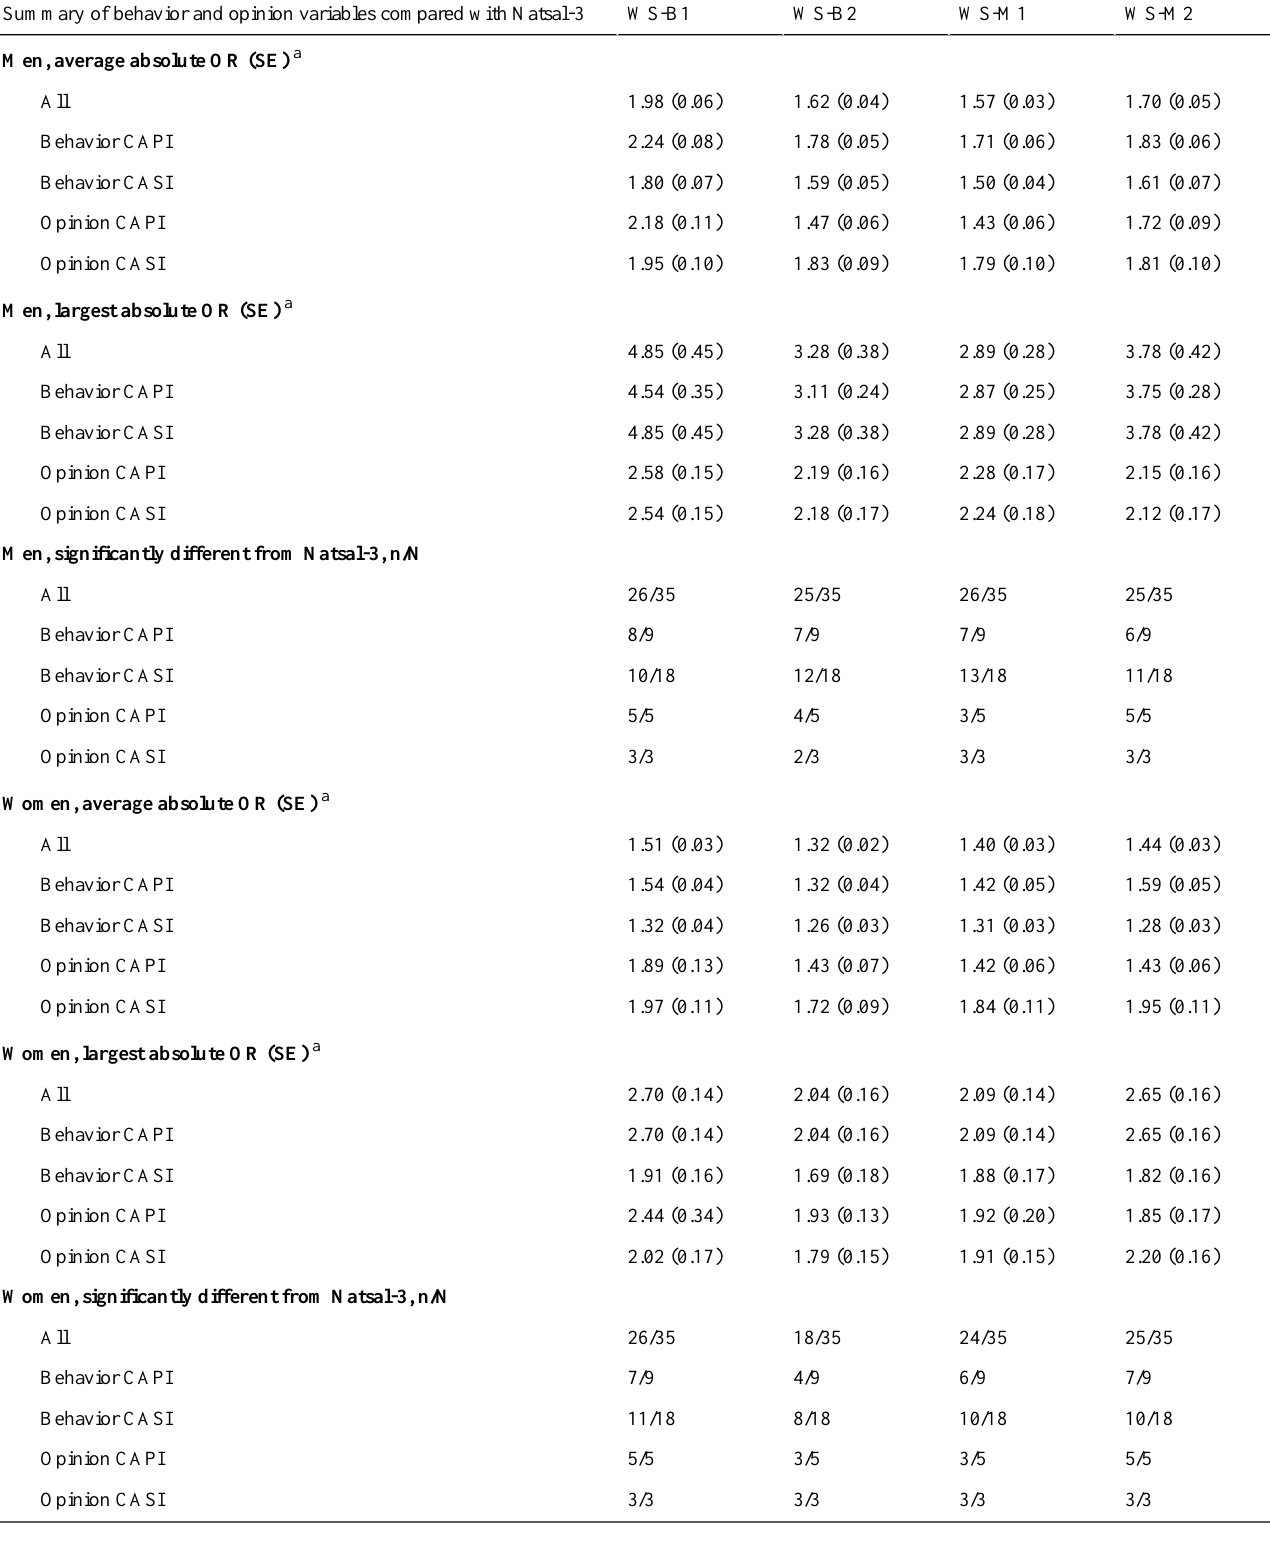
Table 3. Summary of behavior (CAPI/CASI) and opinion (CAPI/CASI) variables for Web survey basic quota 1 and 2 (WS-B1 and WS-B2) and Web survey modified quota 1 and 2 (WS-M1 and WS-M2) compared with Natsal-3 for men and women. WS-M2WS-M1WS-B2WS-B1Summary of behavior and opinion variables compared with Natsal-3 Men, average absolute OR (SE)